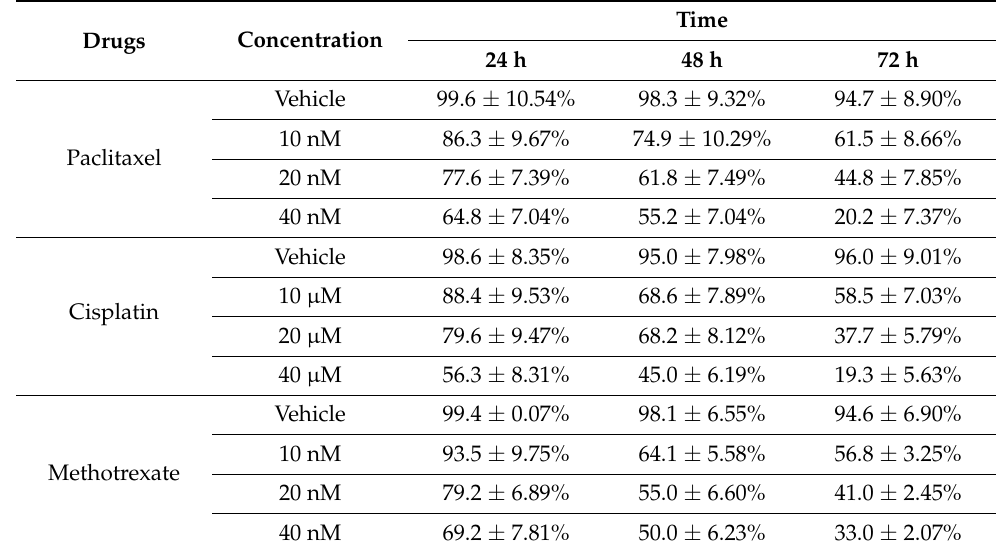
Table 1. Summary of the cell survival rate at the indicated concentrations 24 h, 48 h and 72 h after the drug’s administration.